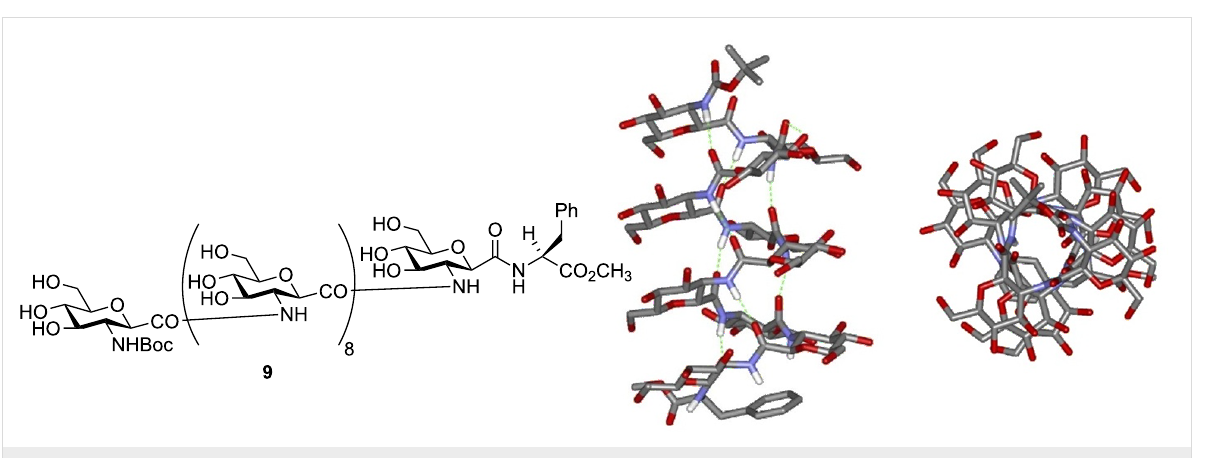
Glycoamino acid-based carbopeptoids are resistant to glycosi- dases and exhibit interesting biological activities. Thus, the O -sulfated β (1 → 2) and β (1 → 6)-linked homo-oligomers effect- ively inhibit L-selectin-mediated cell adhesion, HIV infection and heparanase acitivity in a linkage-specific manner